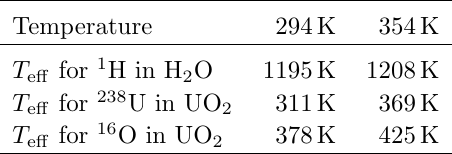
Table 1. Effective temperatures calculated with the H 2 O and UO 2 candidate files for the JEFF-4 library, which is available in the test library JEFF-4T1.